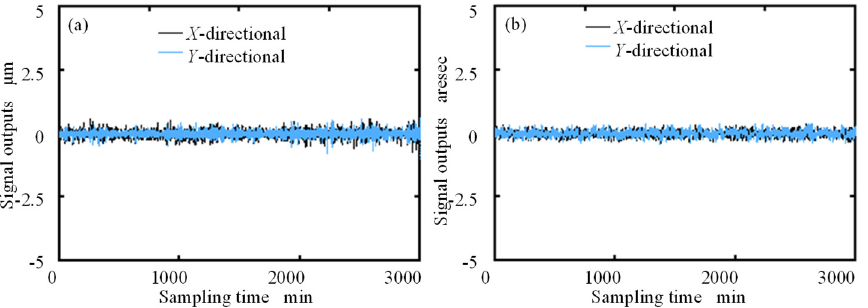
Figure 12. Outputs of ( a ) QD5 and ( b ) QD6 when the IAEC was activated with the BPNN-based PID controller.